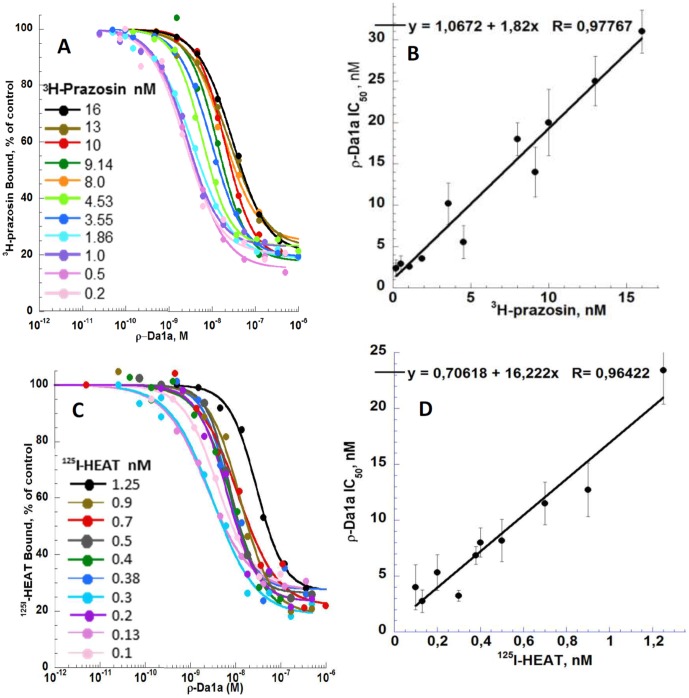
Inhibition of the binding of a series of concentrations of 3H-prazosin and 125I-HEAT to α1A-AR by ρ-Da1a.Panel A 3H-prazosin binding (from 0.2 to 16 nM) inhibited by ρ-Da1a. Panel B 125I-HEAT binding (from 0.1 to 1.25 nM) inhibited by ρ-Da1a. Panel C and D: Fitting, by the Cheng and Prusoff equation IC50 = Ki+Ki(L/Kd), of IC50 values as a function of the radiotracer concentrations.